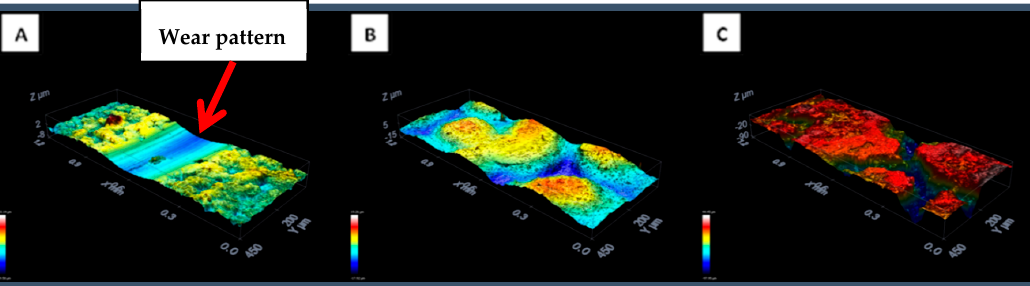
Figure 3. Confocal microscope images showing the wear track after the wear tests of ( A ) PEEK, ( B ) PEEK/BG, and ( C ) PEEK/BG/h-BN coatings.